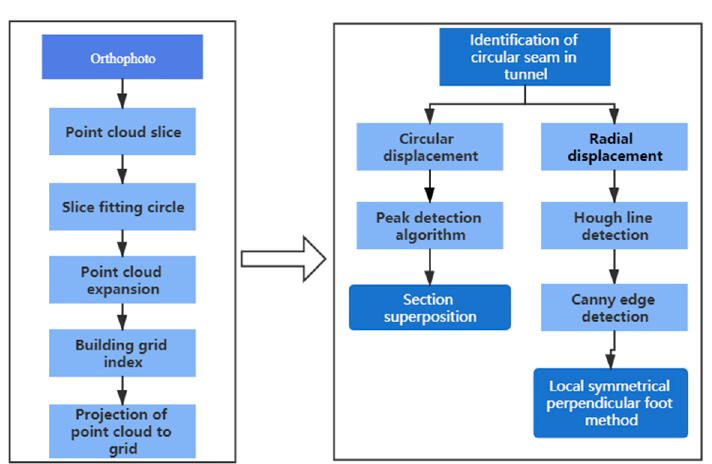
Figure 2. Flow chart of the displacement calculation method.